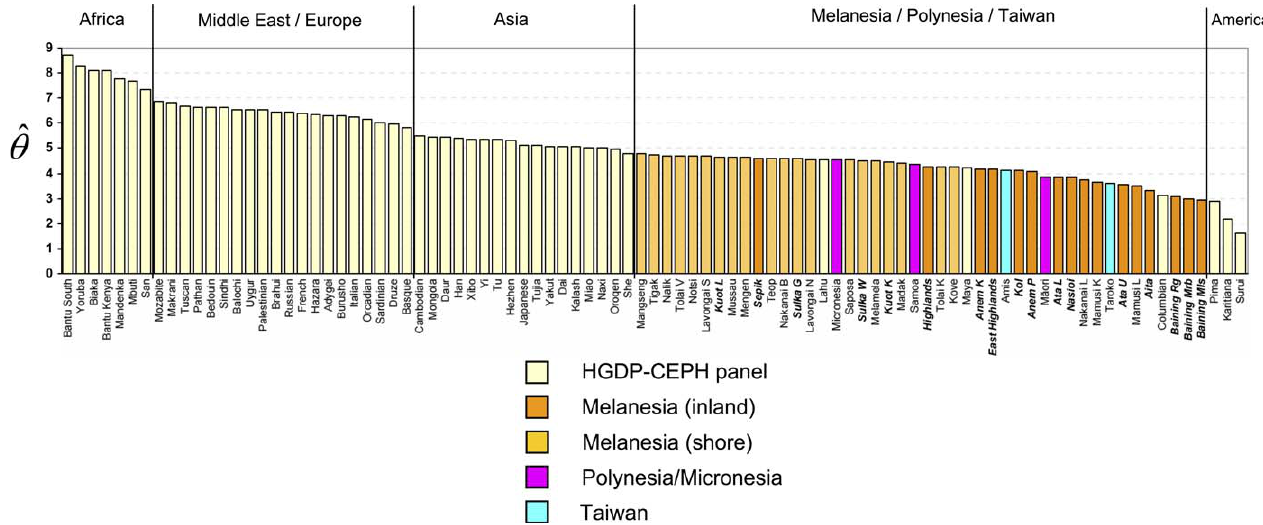
Figure 2. Population Diversity Values of h ˆ for the HGDP-CEPH and Pacific datasets, for 687 microsatellites. Populations are ordered by their declining values of h ˆ , but systematic regional distinctions are indicated by vertical lines. Conglomerate groups tend to have higher values than nearby populations (Bantu South, Sepik, Highlands, Micronesia, Samoa, and Columbia). Papuan-speaking groups are in bold italics; the Melanesian inland/shore distinction is indicated by the two shades of orange. Abbreviated names are spelled out in Table S1.